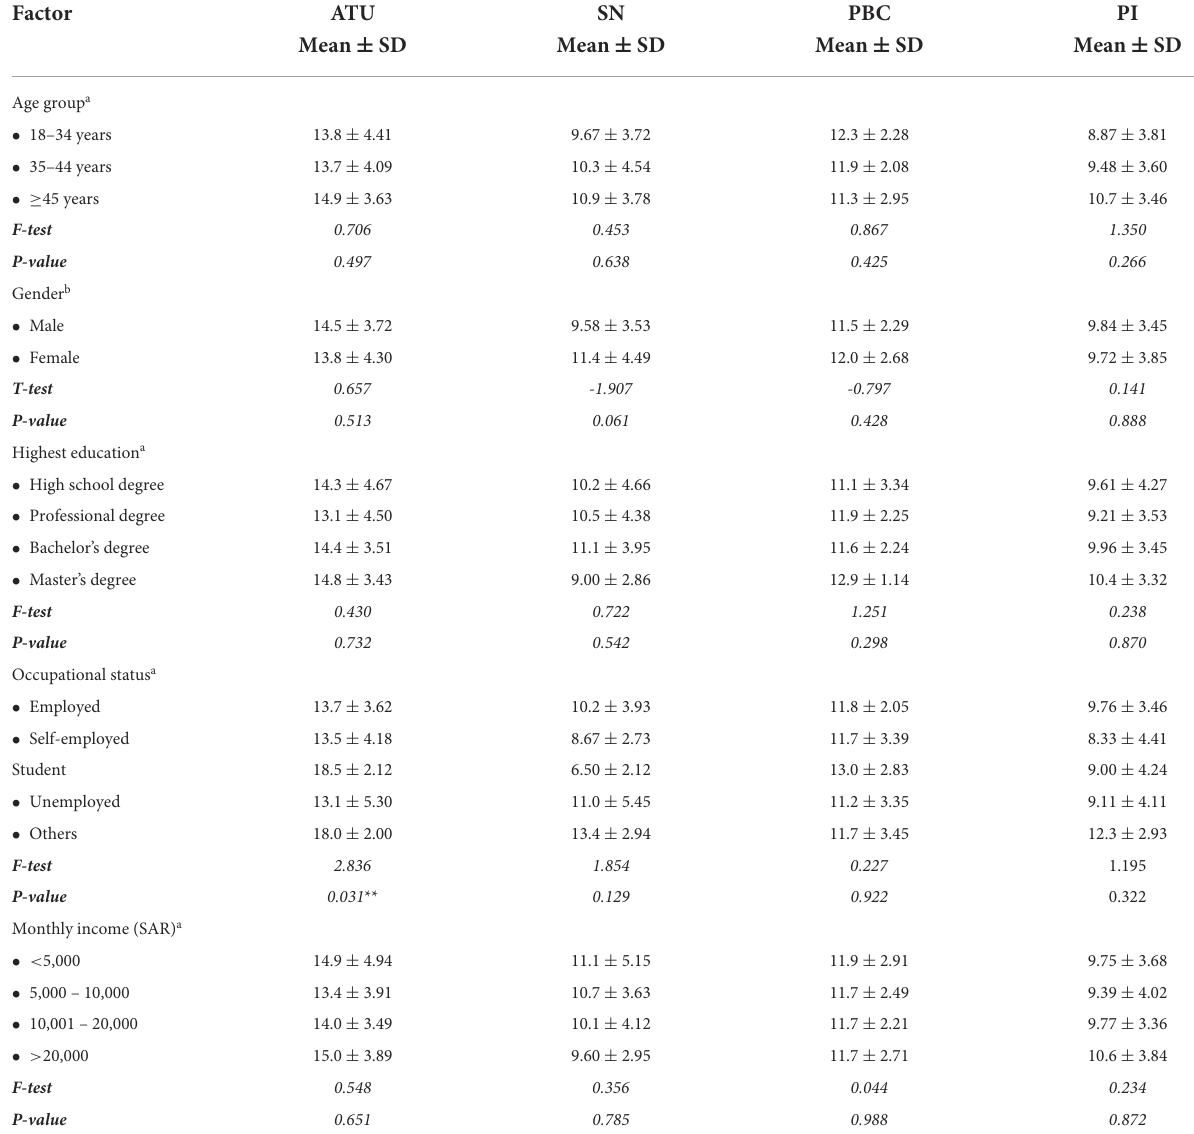
TABLE 6 Comparison between attitude toward using, subjective norm, perceived behavioral control and purchase intention in relation to the socio demographic characteristics of participants. Factor ATU SN PBC PI Mean ± SD Mean ± SD Mean ± SD Mean ± SD